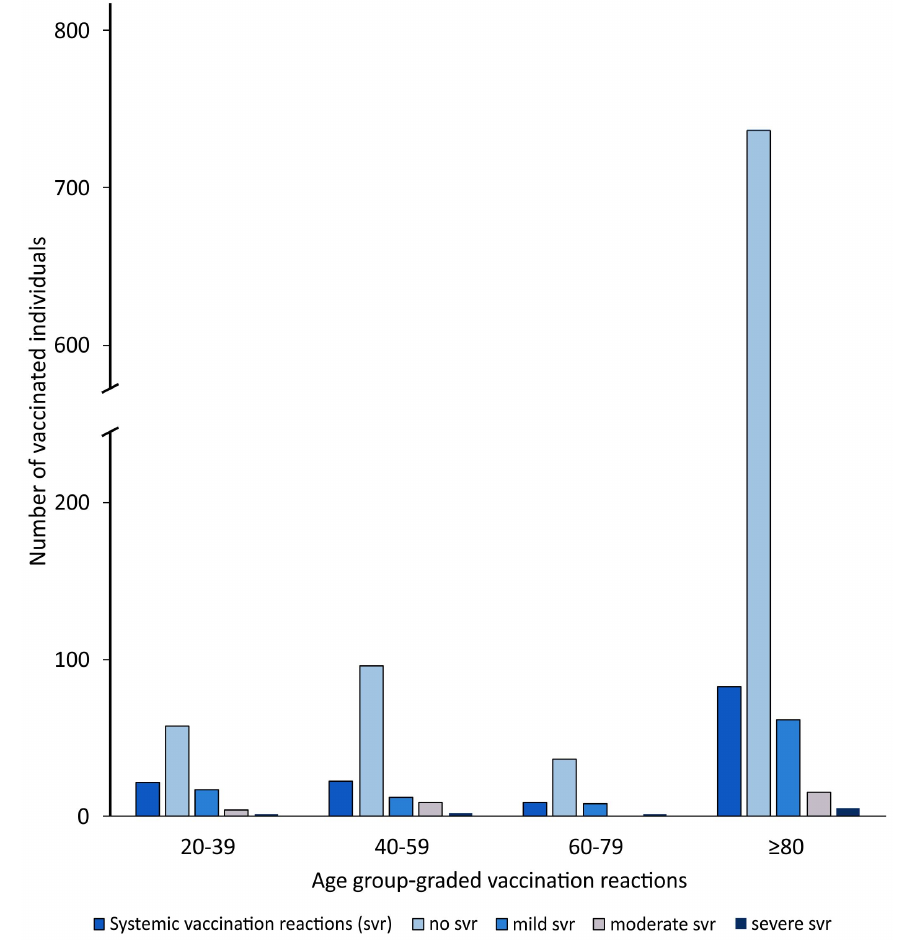
Figure 2. Age group-graded systemic vaccination reactions.